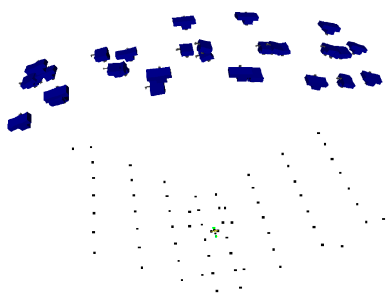
Figure 15. The point array and the photo-taking stations.